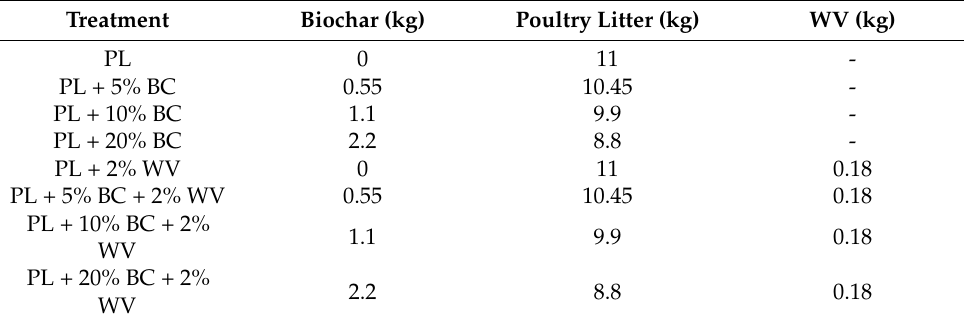
Table 1. Amounts of poultry litter and biochar used for treatments.